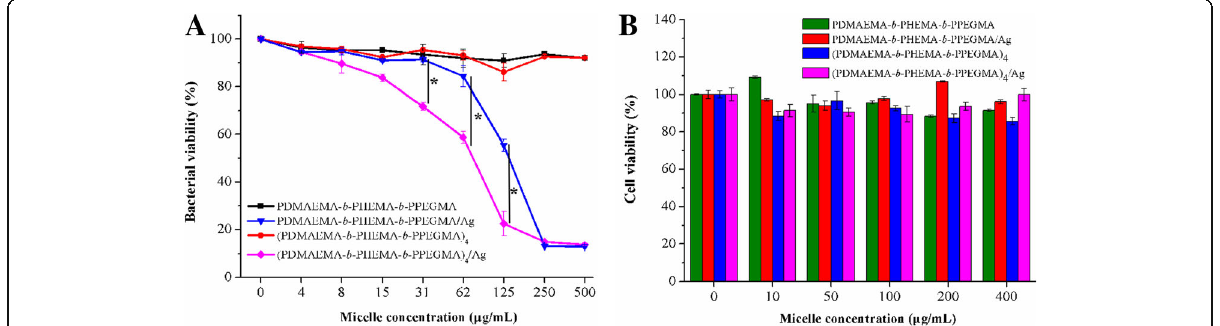
Fig. 7 a Antibacterial activity and b cell viability of linear copolymers and star copolymers micelles stabilized AgNPs at PDMAEMA/AgNO 3 molar ratio = 6/1. * p < 0.05, two-tailed Student t